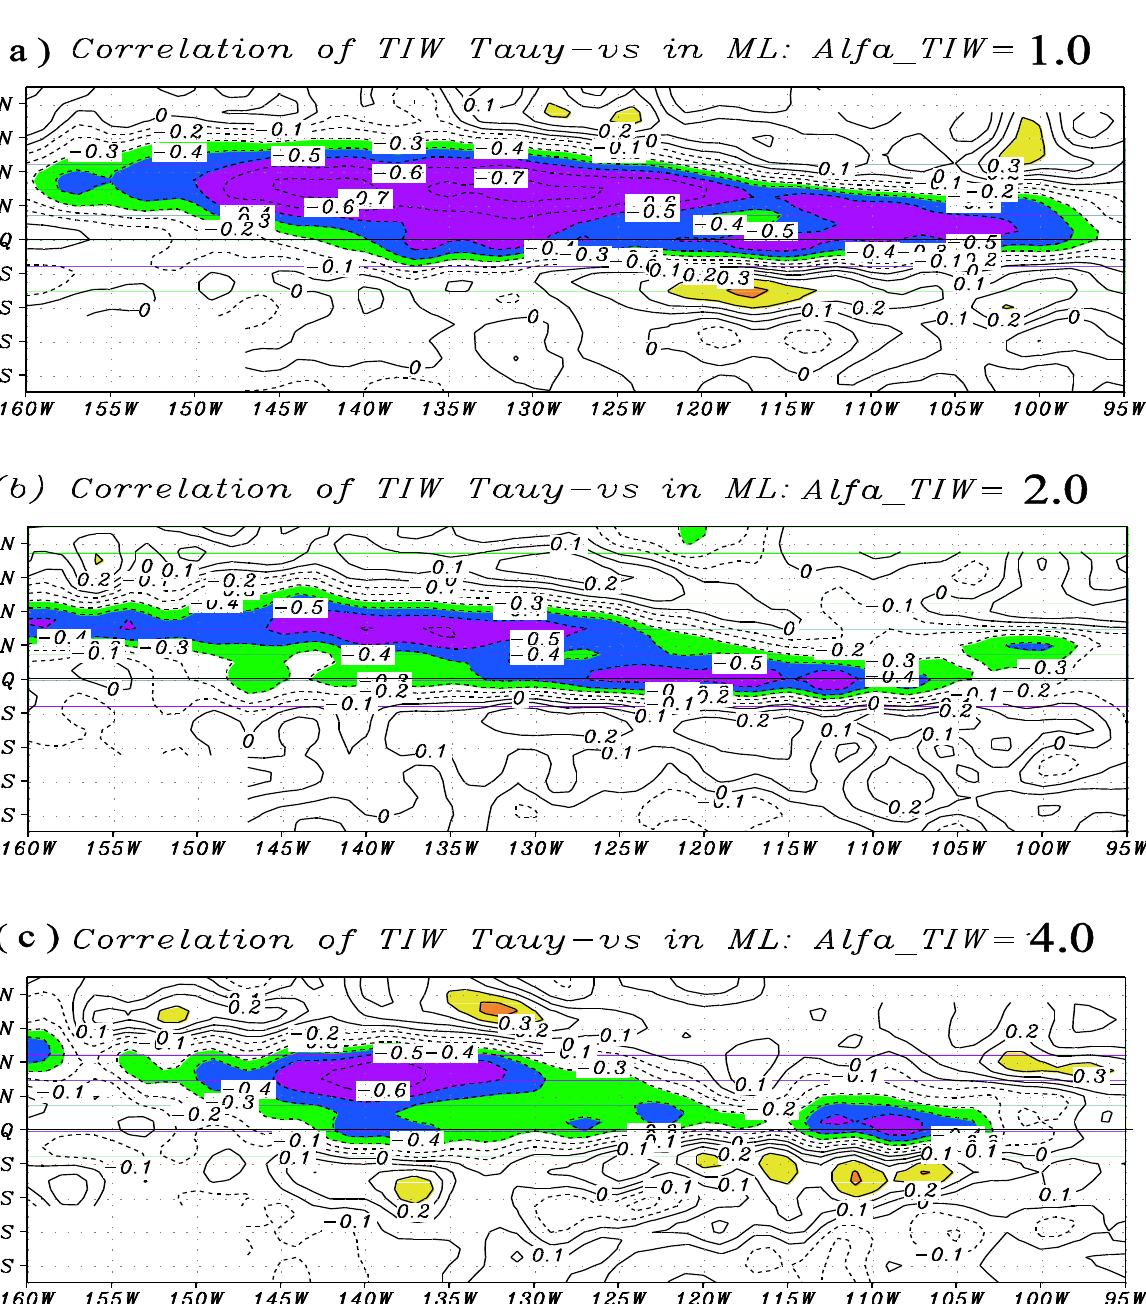
Figure 15. Horizontal distributions of the correlations between the high-pass - filtered meridional wind stress and surface-layer current fields in some additional feedback runs, with ( a ) α = 1.0; ( b ) α = 2.0; and ( c ) α = 4.0, respectively. The calculations are TIW TIW TIW made using daily data in year 13. The contour interval is